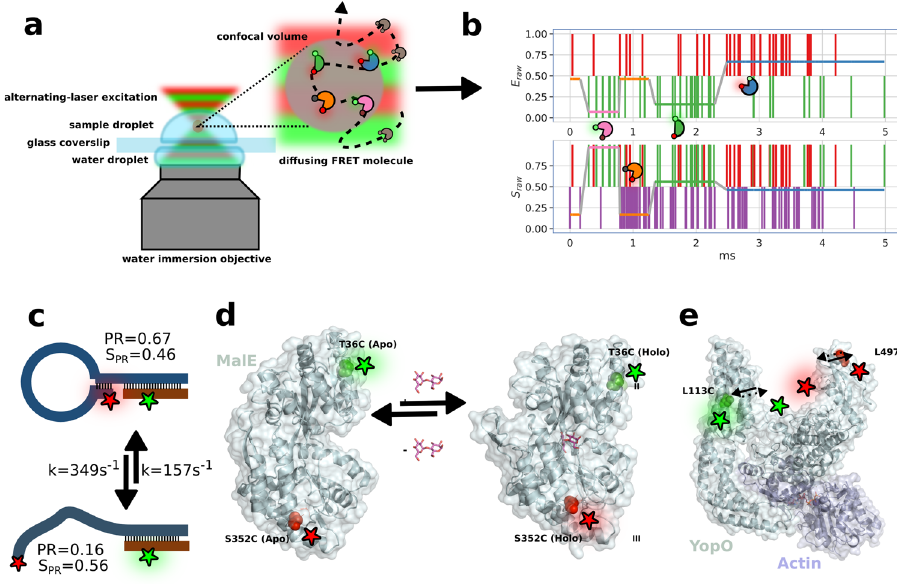
Fig. 1 Cartoon representations of data acquisition, and biological systems examined in this work. a Confocal microscope setup with inset illustrating the diffusive trajectory of a single molecule in and out of the confocal volume, undergoing conformational and photophysical changes, producing, b a photon time trace; photons represented by vertical bars, and the most likely state path according to the Viterbi algorithm overlayed as horizontal colored line. c – e Biological systems studied: c DNA hairpin, d maltose binding protein MalE with structure-guided conformational changes, and e type III secretion effector YopO. See Supplementary Fig. 1 for a version of this fi gure with transition rates, E raw and S raw values included for the biological